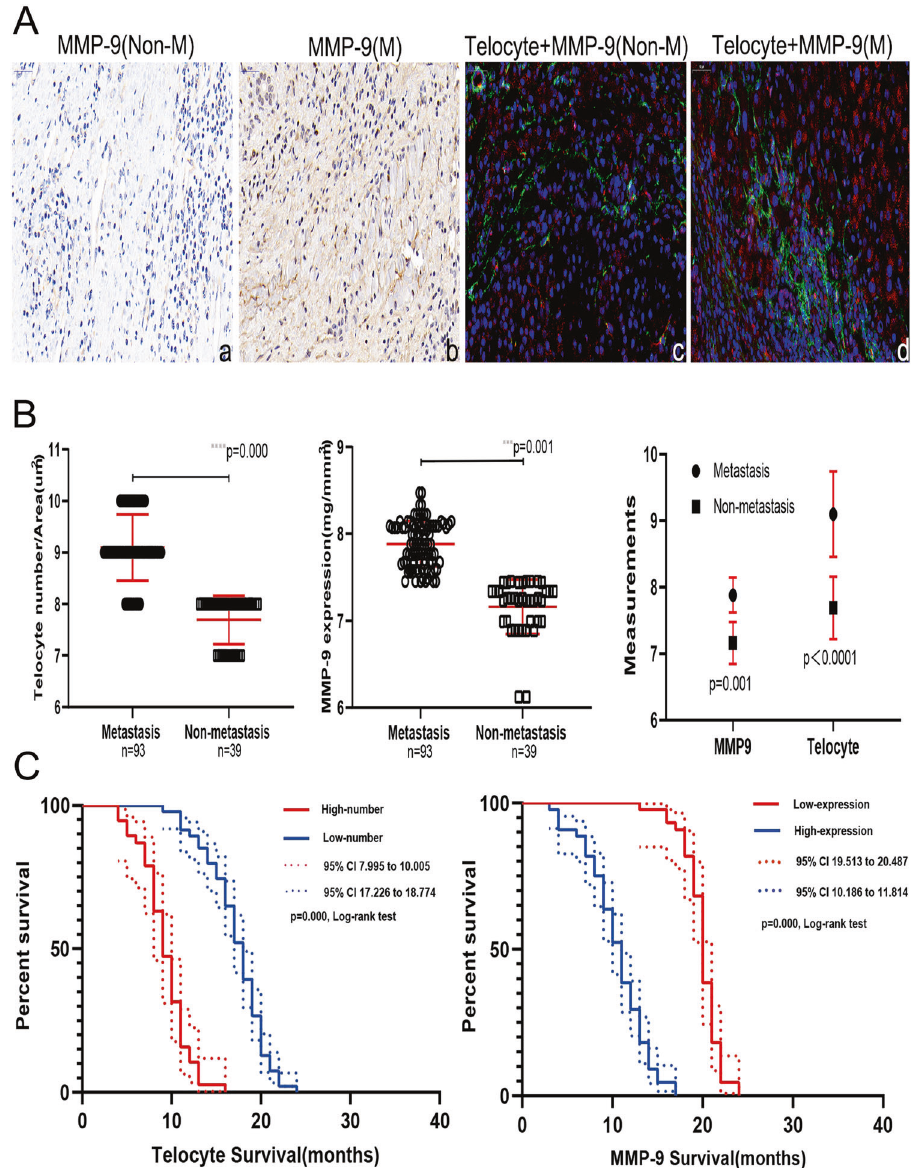
Fig. 3 Comparison of telocyte count and MMP9 expression in HCC para-cancer tissues between the metastasis and non-metastasis groups. A Different MMP9 expression levels in the HCC tissues without metastasis (a) and with metastasis (b) as determined by immunohistochemistry staining. The relationship and distribution of telocytes (green) and MMP9 (red) in the para-cancer tissues are disparate between non-metastasis (c) and metastasis (d) samples as determined by immuno fl uorescence staining. B Telocytes counts and MMP9 expression in the metastasis ( n = 93) and non-metastasis ( n = 39) groups were statistically signi fi cantly different. C Kaplan – Meier analysis of overall survival (OS) in HCC patients ( n = 265) with low (red line) or high (blue line) telocyte counts (left panel) and low (red line) or high (blue line) MMP9 levels (right panel) ( p < 0.05, Log-rank test). **** p < 0.001, **** p =